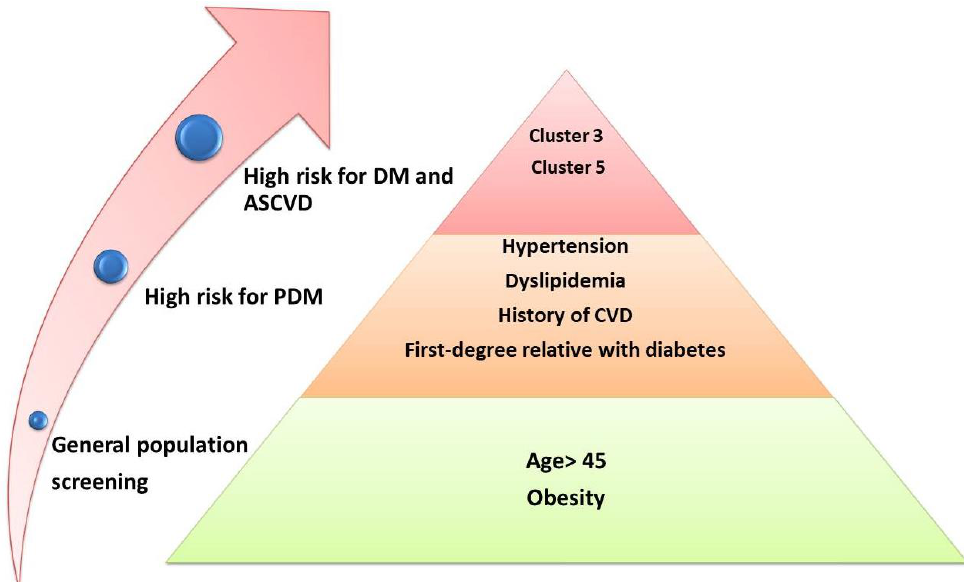
Figure 2. A stratified screening process for prediabetes. ASCVD, atherosclerotic cardiovascular disease; cluster 3, high-risk prediabetic phenotype with low insulin secretion and high genetic risk; cluster 5, high-risk prediabetic phenotype, high liver fat content, and high IR [31]; CVD, cardiovascular disease; DM, diabetes mellitus; PDM, prediabetes.